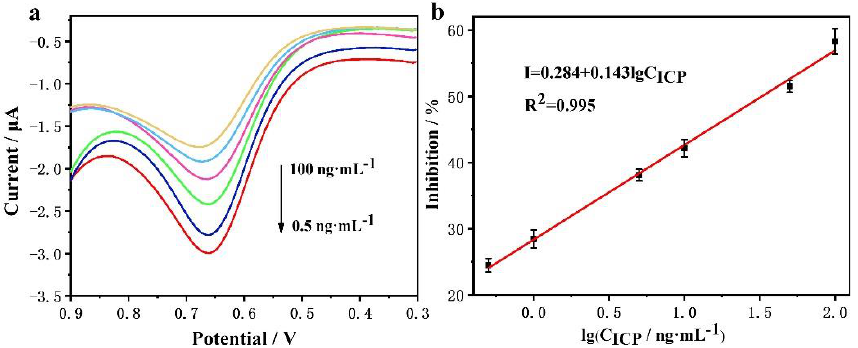
Figure 6. ( a ) DPV response of AChE-CS/GR/ZIF-8/GCE after ICP inhibition at different concentra- tions (0.5, 1, 5, 10, 50, 100 ng/mL) in 1 mM ATCl PBS solution. ( b ) Calibration curve of inhibition rate and the logarithm of ICP concentration.